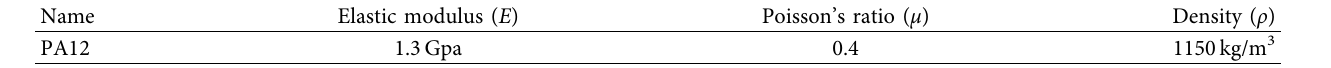
Table 1: Mechanical parameters of BQZSS.